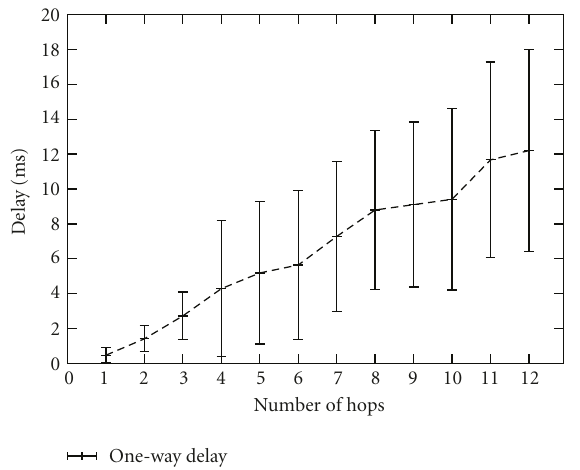
Figure 27: Evaluation of the ping sessions in di ff erent scenarios. Table 4: OLSR values used for the mobility scenarios. Parameter Used Values